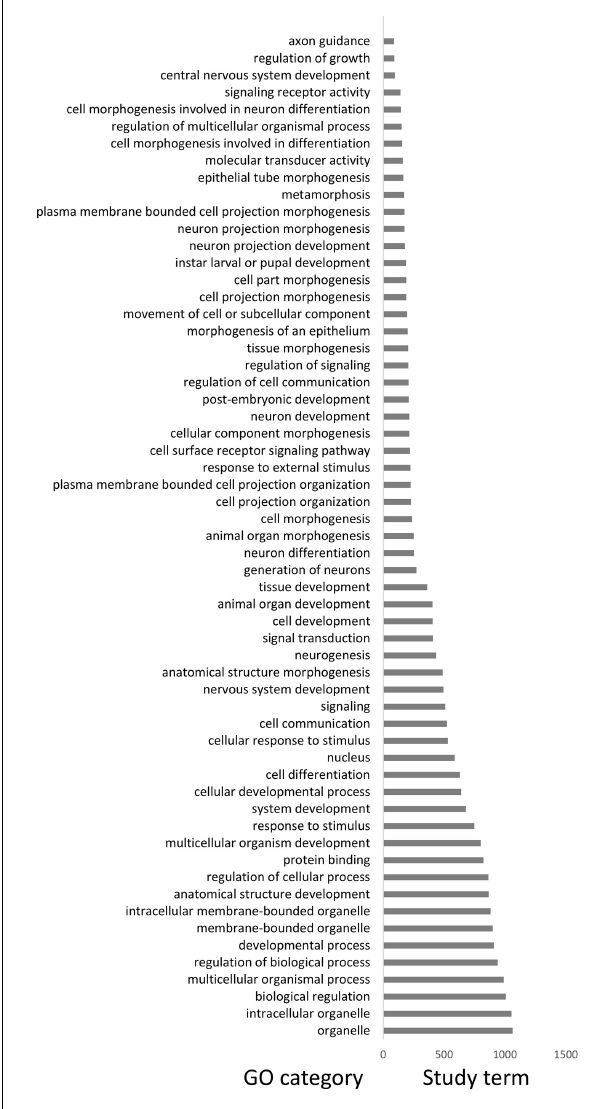
FIGURE 6 | Gene ontology enrichment results of population specific structural